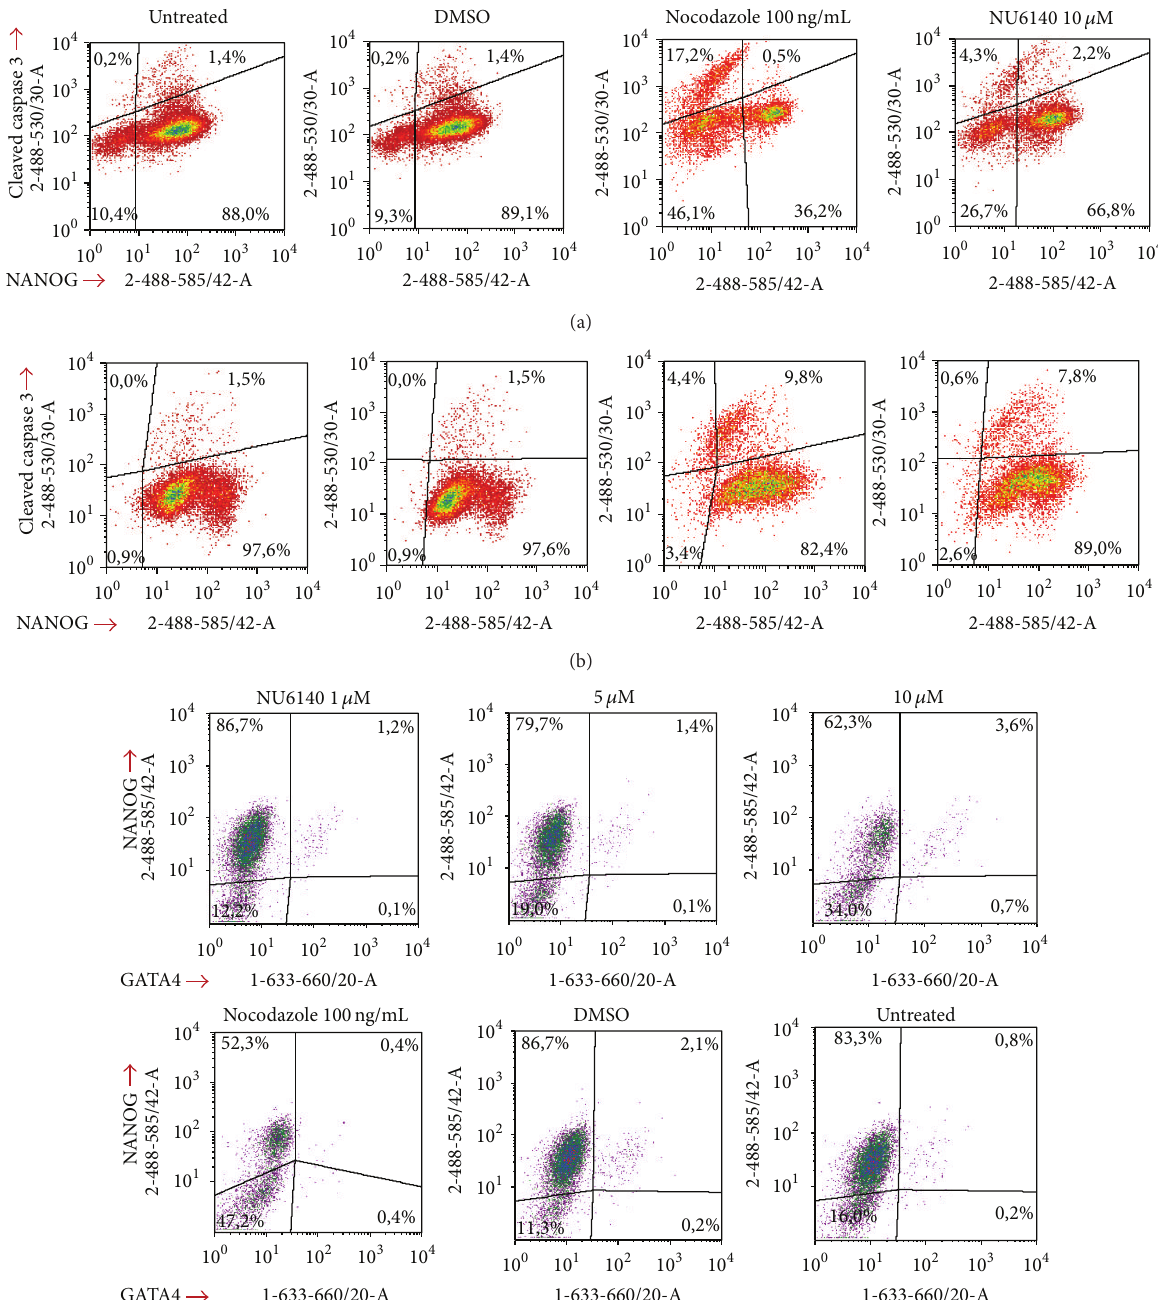
Figure 4: NU6140 treatment increases population of apoptotic hES and hEC cells. Fixed and permeabilised hES and hEC cells were stained with anti-cleaved caspase 3 (Alexa Fluor 488 conjugate) and anti-NANOG (PE). Other hES cells were stained with anti-GATA4 (Alexa Fluor 647) and anti-NANOG (PE conjugate) antibodies and with DAPI. For analysis cellular debris and doublets were excluded. (a, b) The correlation of cleaved-caspase 3 expressing cells and NANOG expression in hES (a) and in hEC (b) cells, respectively. (c) The number of GATA 4 expressing cells and the correlation with NANOG expression in hES